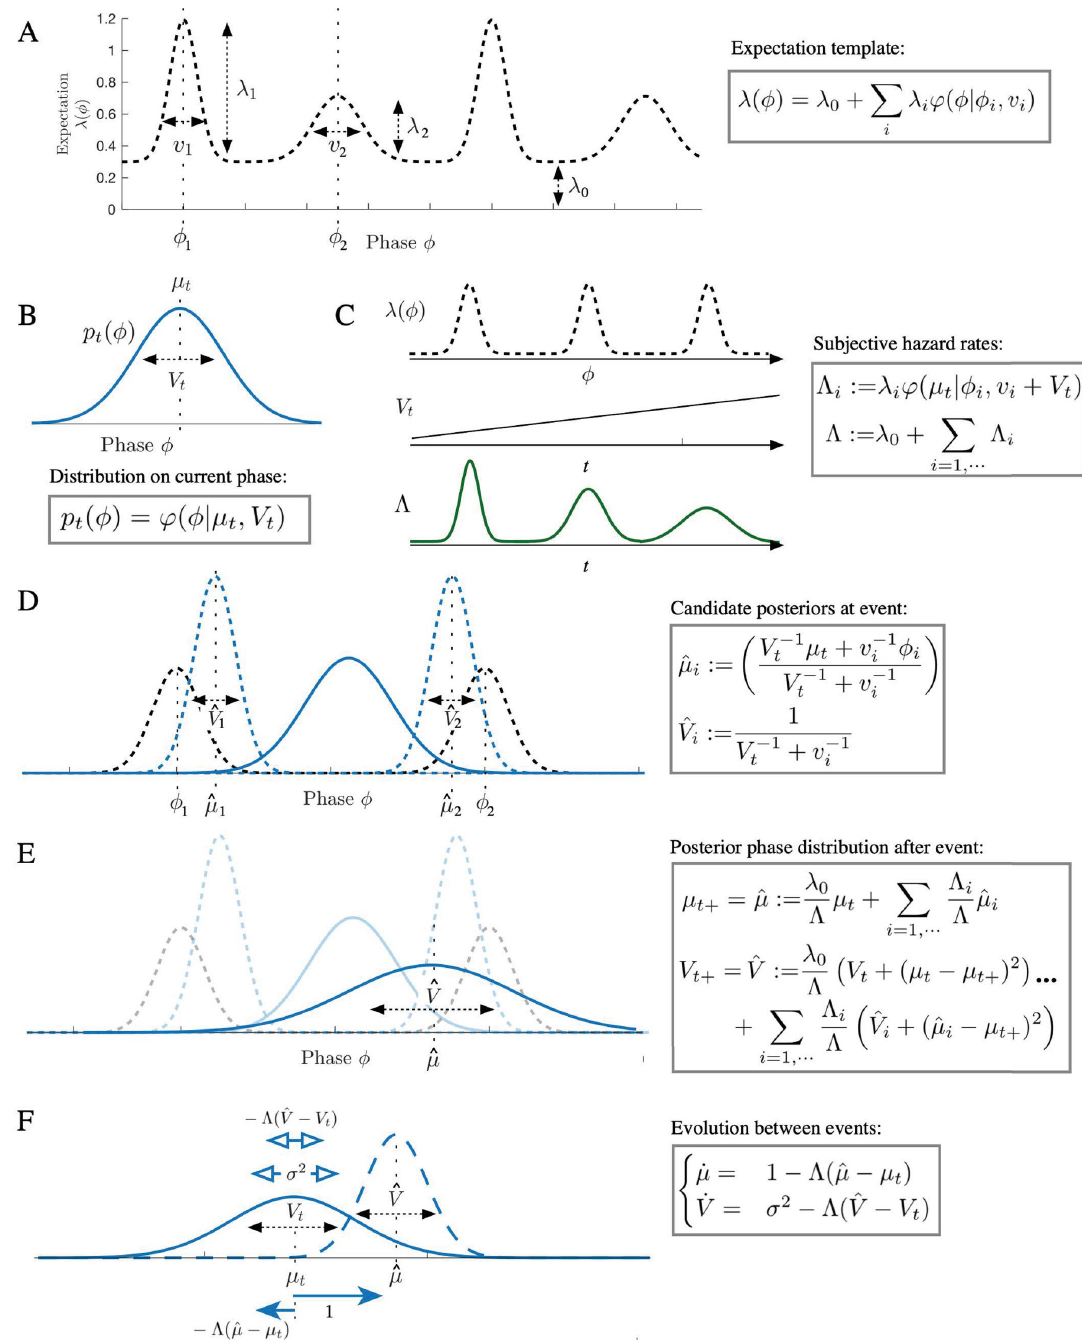
Fig 1. Illustration of the PIPPET filter. A) In the PIPPET generative model, λ ( ϕ ) represents the instantaneous rate of events occurring when the underlying temporal process is at phase ϕ . This is assumed to be a sum of Gaussian-shaped functions with means ϕ i representing the phases at which specific events are expected, variances v i representing (the inverse of) the temporal precision of the expectations, and scales λ representing the strength of the expectations. A constant λ 0 is also added, representing the instantaneous rate i of events unrelated to phase. B) At any time t , the filter’s estimate of current phase p t ( ϕ ) is forced to be a Gaussian with mean μ t (the (the level of uncertainty about the phase estimate). C) These allow us to define a subjective estimated phase at time t ) and variance V t hazard rate Λ (implicitly a function of time) representing the degree to which an event is anticipated at t , and conditional subjective hazard rates Λ representing the degree to which an event is anticipated from peak i . These hazard rates become less precise as phase i uncertainty V t increases. D) Each peak i of λ is associated with a “candidate posterior” with mean ^ m and variance ^ V —this would be i i